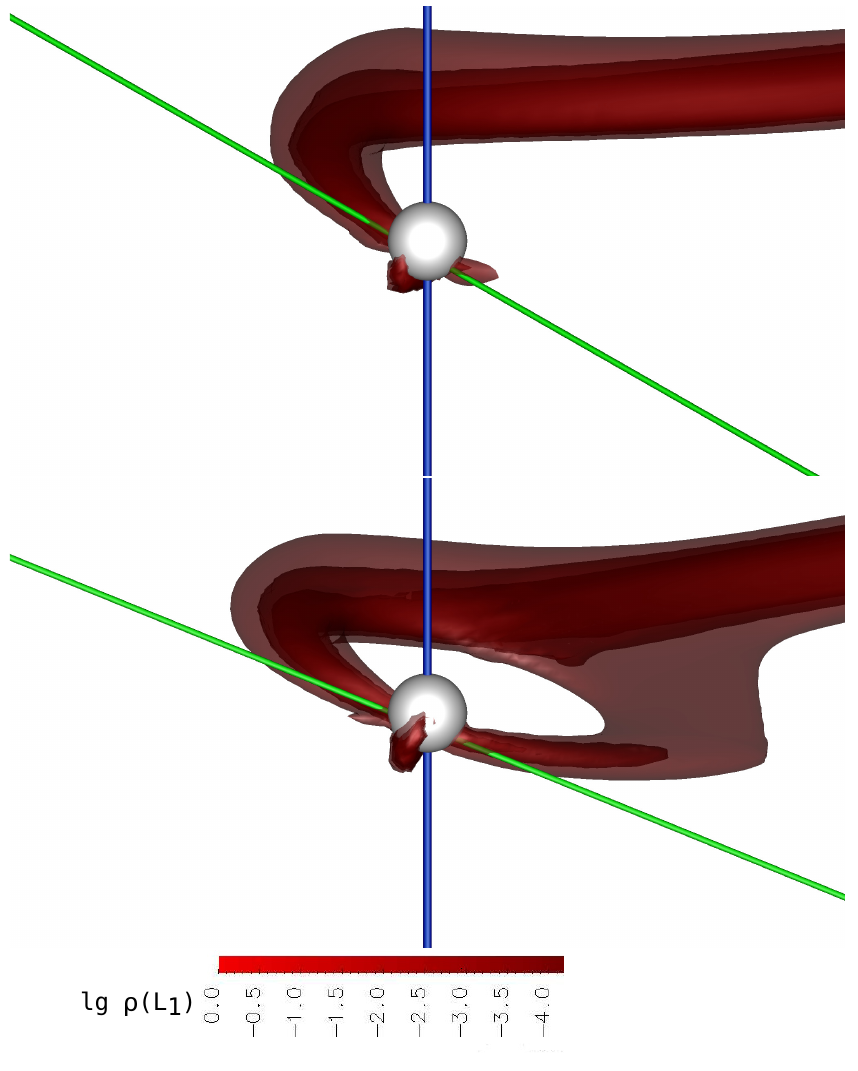
Figure 13. The three-dimensional numerical modeling results of the flow structure in the asyn- chronous polar with an offset dipole for the moment of switching from the north magnetic pole to the south one. The iso-surfaces of the decimal logarithm of the density are presented in units of ρ ( L 1 ) . The flow structure represented near the accretor. The accretor is indicated as a white sphere. The binary system is at the orbital phase 0.65. The upper panel coincides with Phase 1, and the lower panel coincides with Phase 2 of the switching